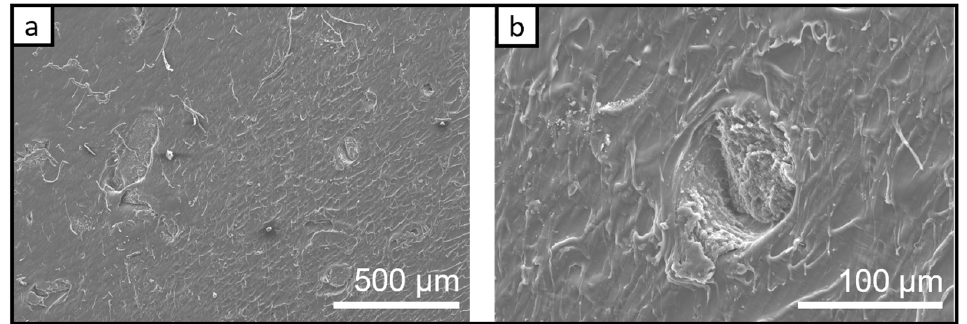
Figure 6. Representative SEM micrographs of bio ‐ PA1010 filled with LDH ‐ 5% nanocomposites after thermal treatment at 145 °C ( a ) and low magnification image showing the smooth surface of the sample detailed view of the plastic deformation that occurred in the sample ( b ).